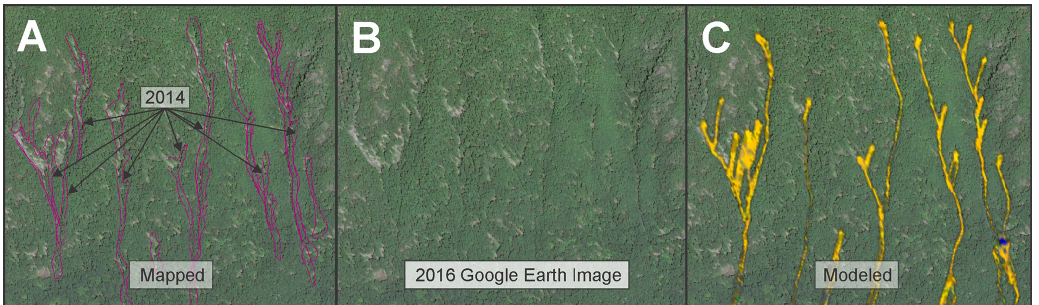
Figure 17. Mapped landslides from 2014 images (a) in the study area were typically wider than observed (b) or modeled landslides (c) in the study area and resulted in mapped magnitudes about twice that of modeled magnitudes for the same frequency of occurrence. Background image © Google Earth, 2016.